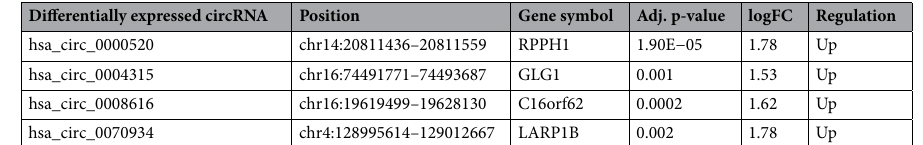
Table 1. Basic information of the four